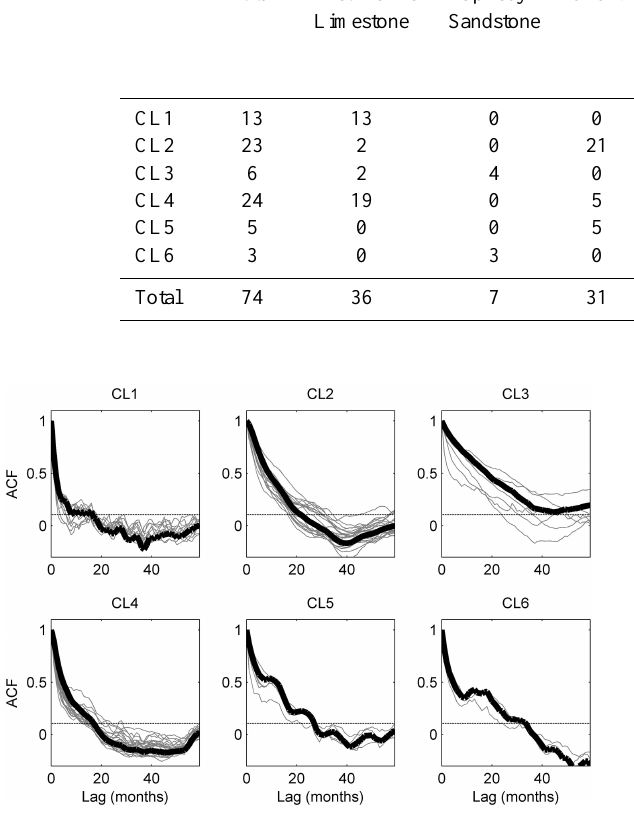
Figure 8. Correlograms for each of the mean SGI time series (bold) and individual site time series (grey) for each of the six k -means clusters showing variation in the autocorrelation function (ACF) for lags up to 60